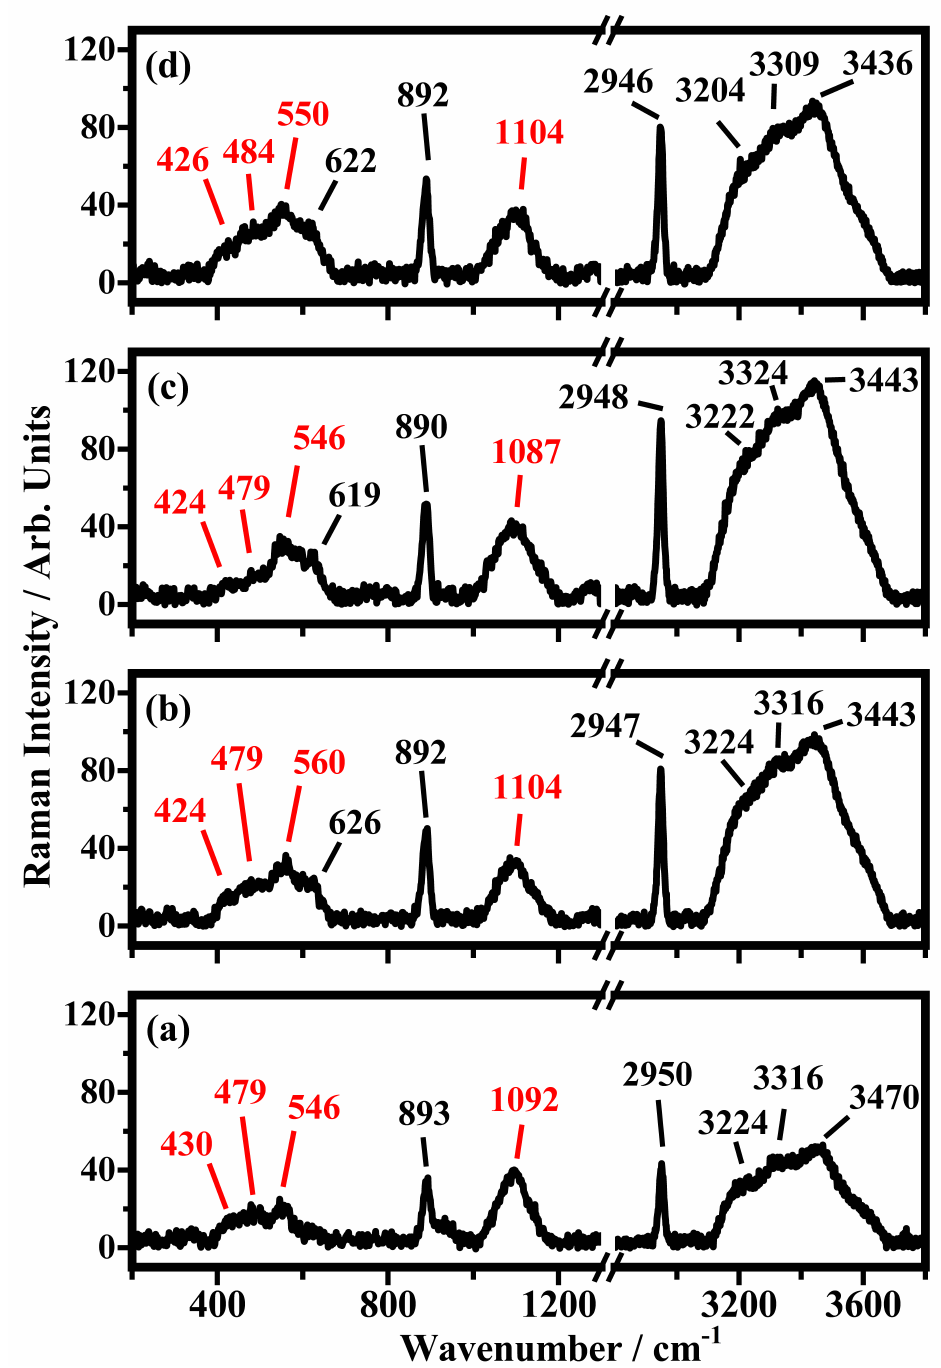
Figure 4. Representative Raman spectra of 10% v / v acetic acid solution in the ranges between 200 and 1300 cm − 1 and between 2800 and 3800 cm − 1 on ( a ) GGPE 0 (glass substrate/GNPs), ( b ) GGPE 3 (glass substrate/GNPs/3 layers of PE material), ( c ) GGPE 11 (glass substrate/GNPs/11 layers of PE material), and ( d ) GGPE 21 (glass substrate/GNPs/21 layer of PE material). The modes of the substrates are in red, while the modes of the solutions are in black. The peaks have been identified by comparisons with other spectra in the